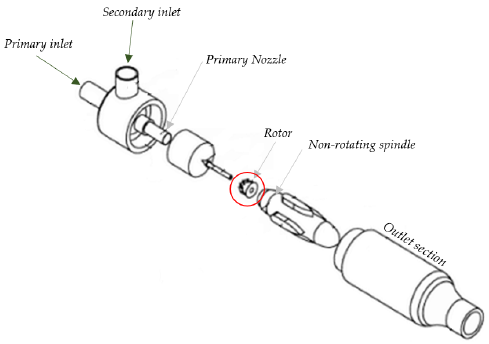
Figure 18. Free spinning pressure exchange device in ejector by Garris et al.